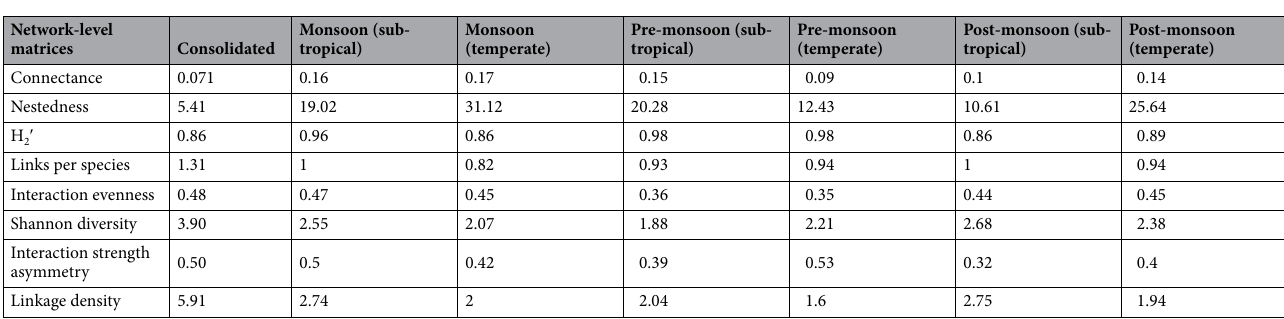
Table 1. Seasonal and altitudinal wise network-level matrices of settling moth-plant pollen transfer